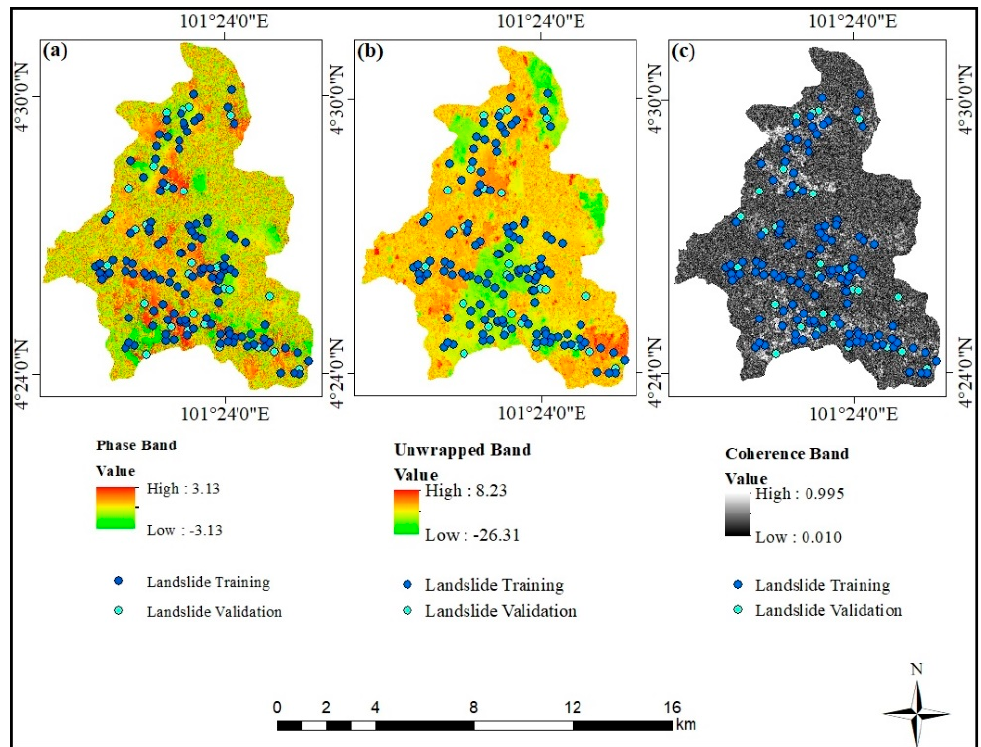
Figure 6. Landslide inventory detection process; Landslide locations on ( a ) phase band, (b ) unwrapped band, and ( c ) coherence band.